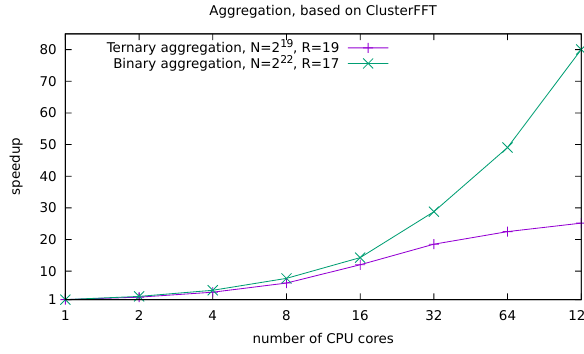
Figure 9: Parallel binary and ternary aggregation solvers on CPU, Ballistic-like kernels, 16 and 10 time-integration steps for N = 2 22 and N = 2 19 nonlinear ODEs, respectively. Parameter R denotes the rank of used matrix and tensor decompositions.